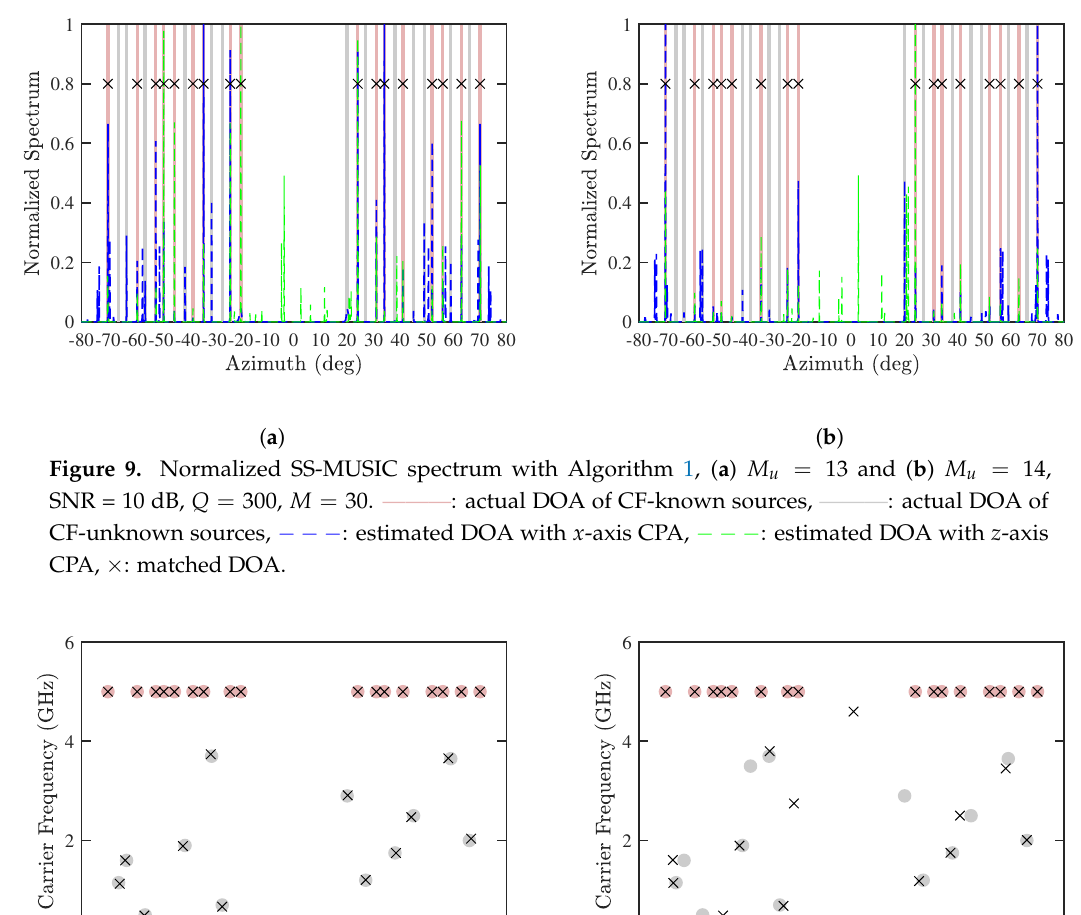
Figure 10. Joint estimation of DOA and CF with proposed PJE algorithm, ( a ) M u = 13 and ( b ) M u = 14, SNR = 10 dB, Q = 300, M = 30. • : CF-known sources, • : CF-unknown sources, × : estimated